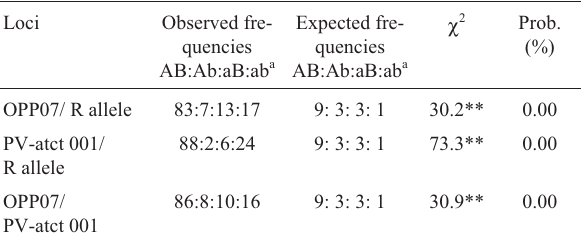
Table 2 - χ 2 test of the segregation observed among the F 2:3 families. considering independent assortment of the markers and the reaction gene loci pairwise.